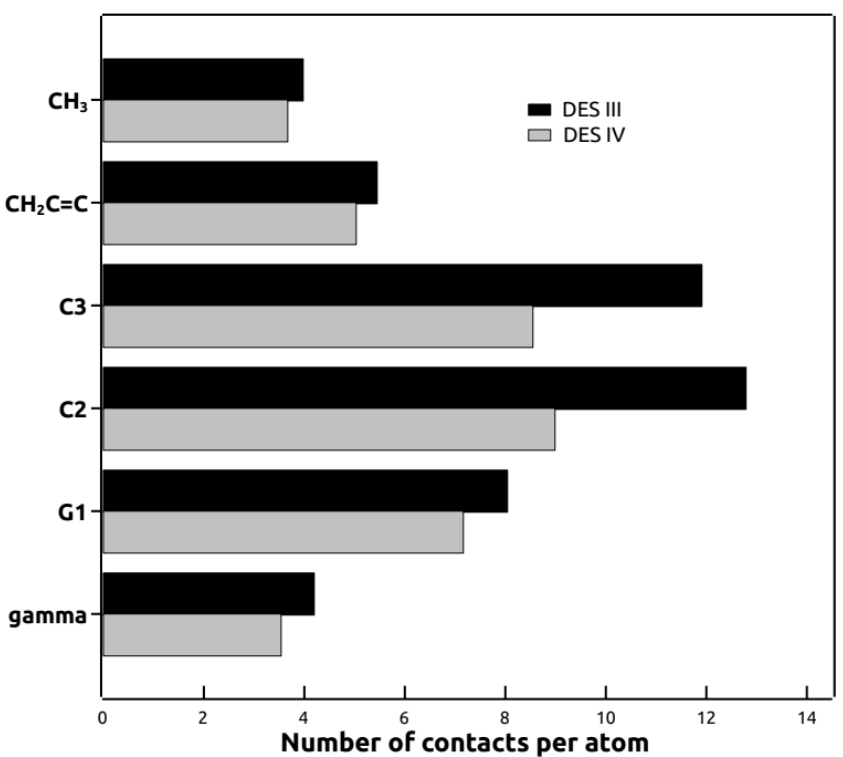
Figure 8. Number of contacts between selected atoms from DES and selected atoms from POPC calculated with mindist function of GROMACS for a trajectory of 60 ns. DES molecules were mainly found close to the polar interface of the bilayer, although a few of them could also be found in the hydrophobic core of the membrane, as also seen in the mass density profiles (Figure 7).